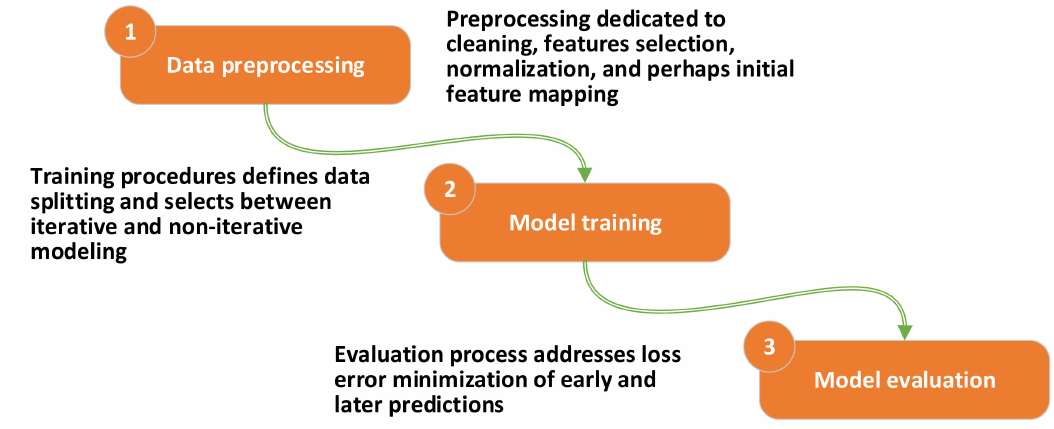
Figure 7. Training steps of ML model for RUL